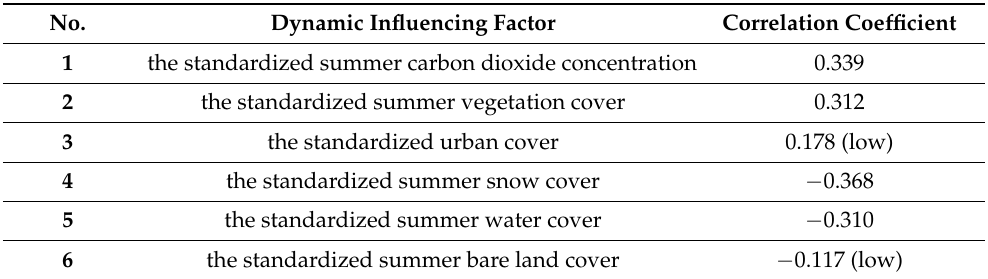
Table 4. Correlation coefficients between the standardized temperature change and dynamic influ- encing factors in summer.